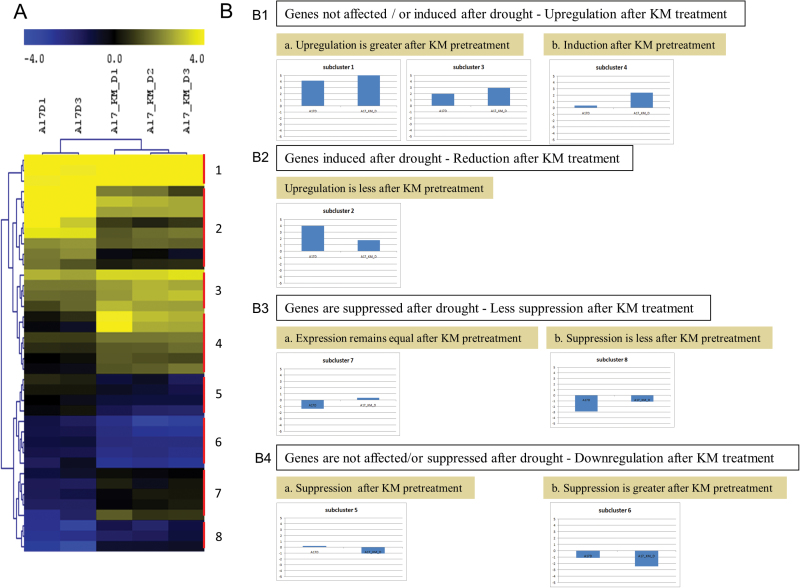
Effect of KM pre-treatment in drought-stressed regulated proteolytic genes. (A) Hierarchical clustering of significantly expressed genes D_Km vs. D (FDR; P<0.05) involved in proteolysis. (B) Summary of the expression profiles per subcluster based on the average of the median-centred values of genes belonging to the subcluster. (This figure is available in colour at JXB online.)